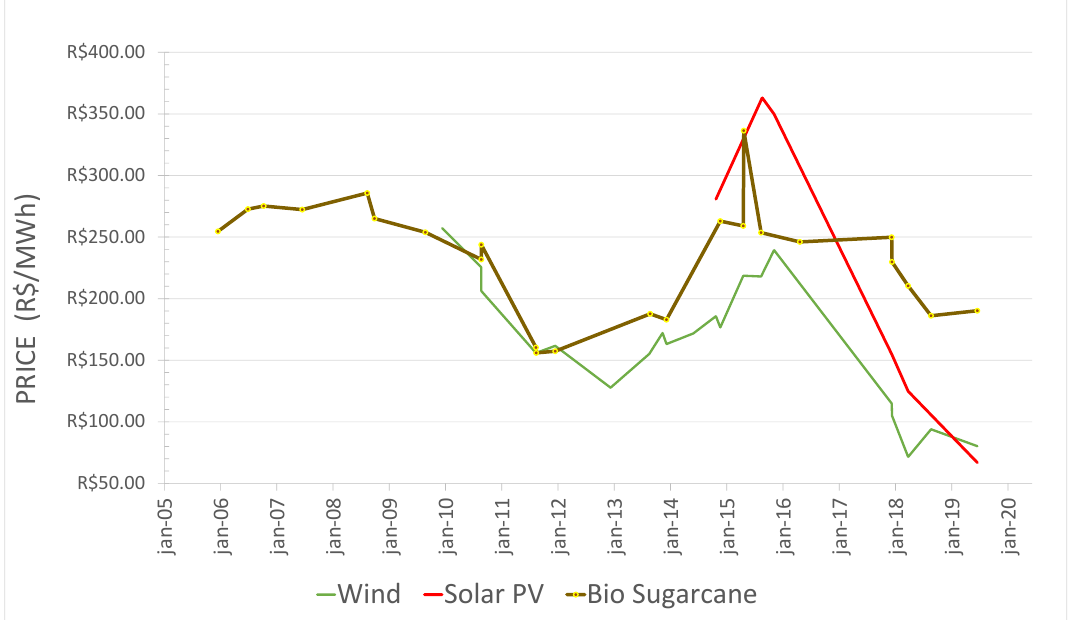
Figure 3. Auction prices (R$/MWh) for all energy sources from 2005 to 2019 Based on [43,44].